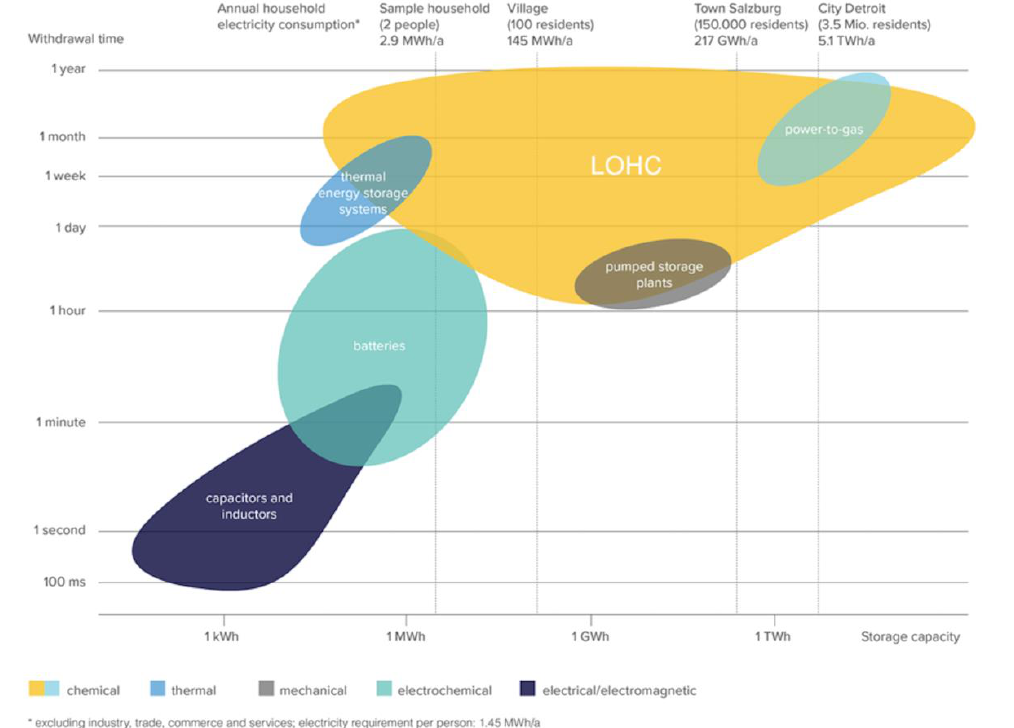
Figure 1 . LOHC compared to other storage materials